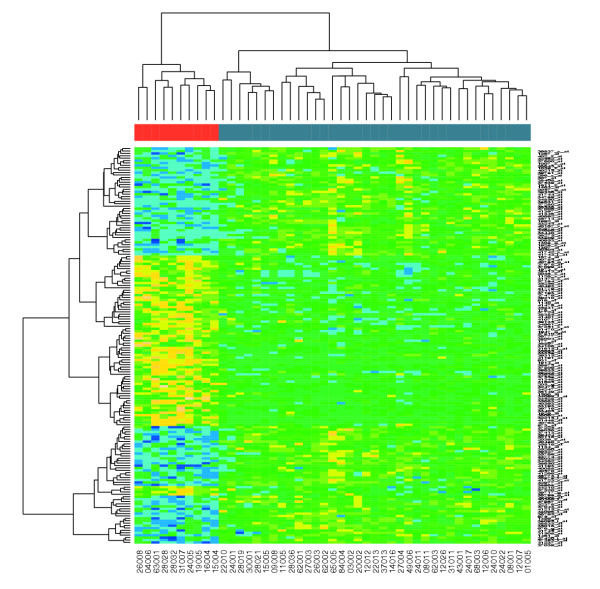
Heat map (produced by the Bioconductor function heatmap()) of the ALL leukemia data.